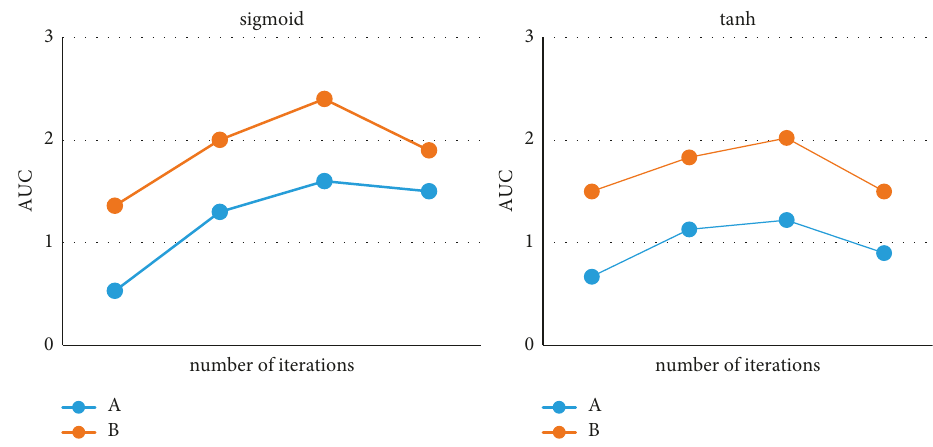
Figure 12: AUC change graph of GRU under different activation functions.